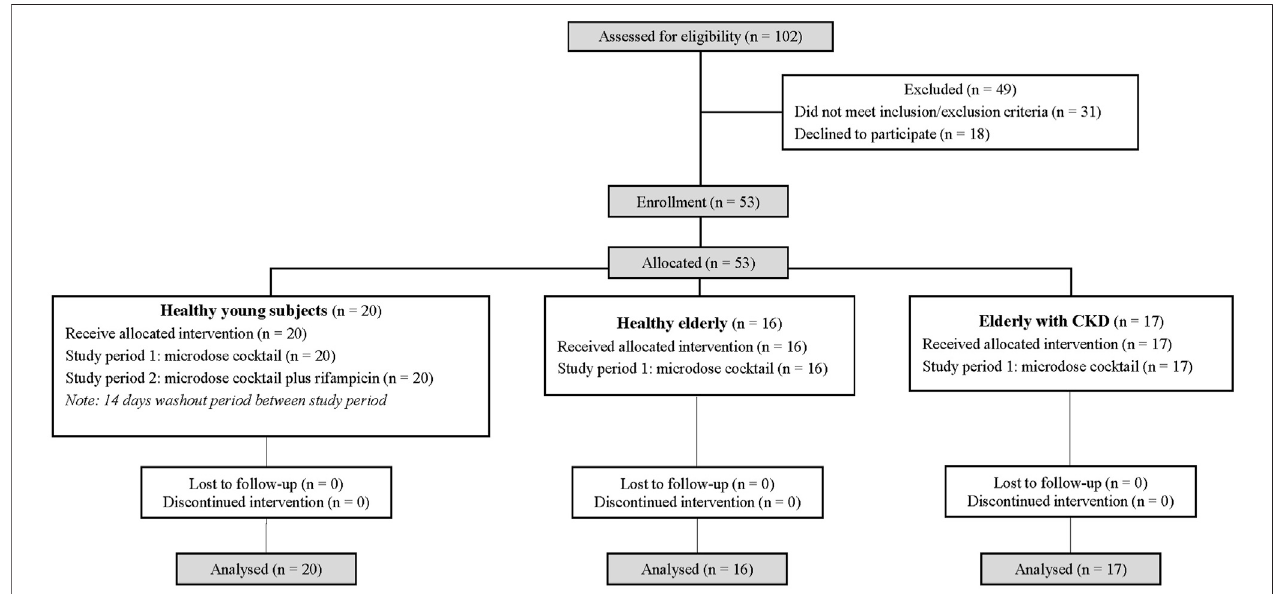
FIGURE 1 | Study fl ow